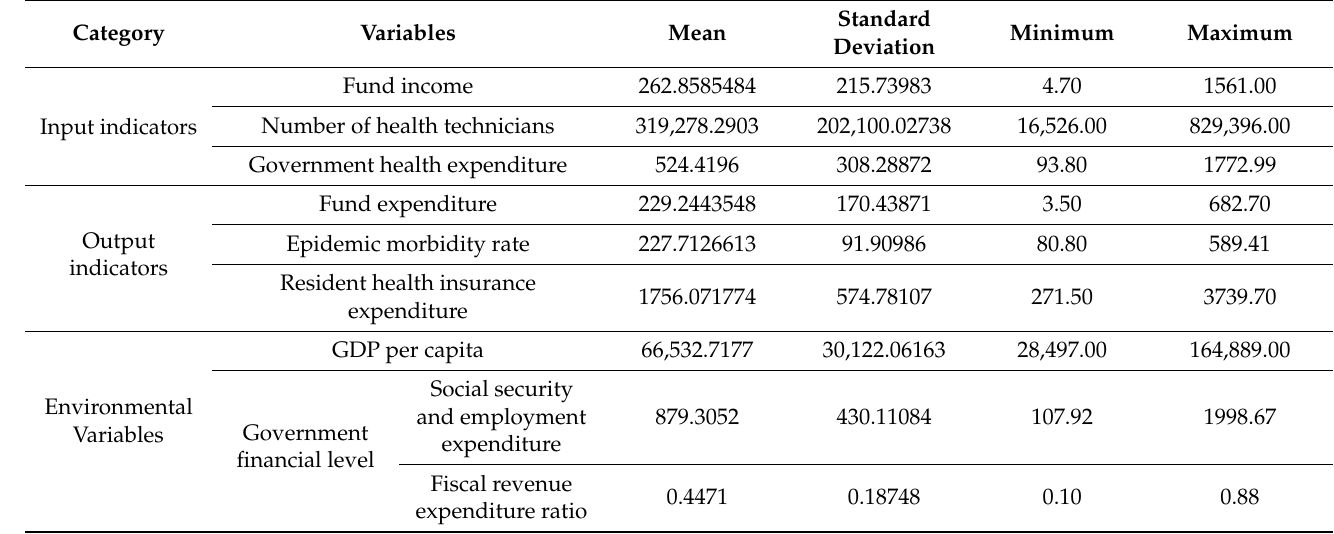
Table 2. Descriptive Analysis of the Inputs, Outputs and Environmental Variables.